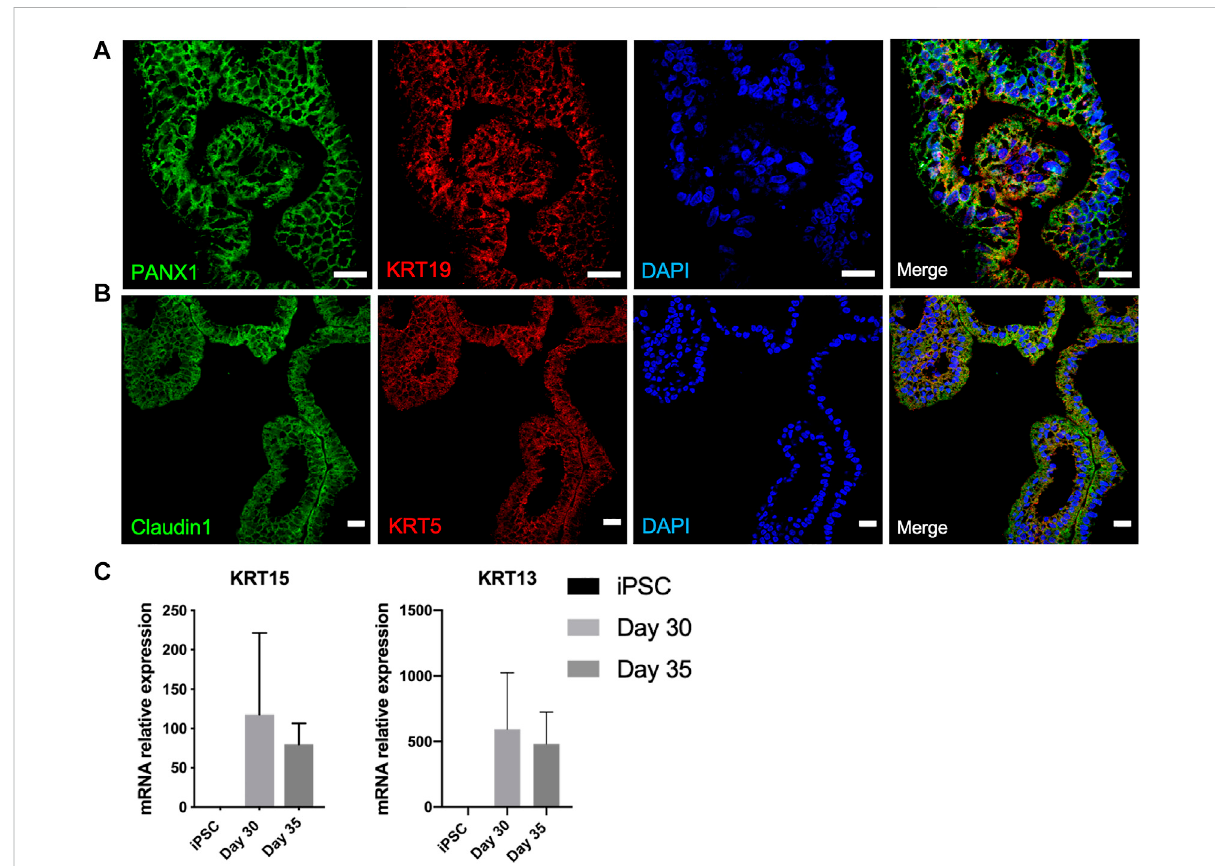
FIGURE 4 Characterization of developing lacrimal gland acinar and ductal cells on day 40 of differentiation (A) IF staining of PANX1+/KRT19 + lacrimal gland luminal ductal cells (B) IF staining of Claudin1+/KRT5+ lacrimal gland acinar cells (Figures are representative of three independent differentiation experiments, scale bar: 20 µm) (C) Decreasing trend in mRNA expression of lacrimal gland progenitor markers KRT15 and